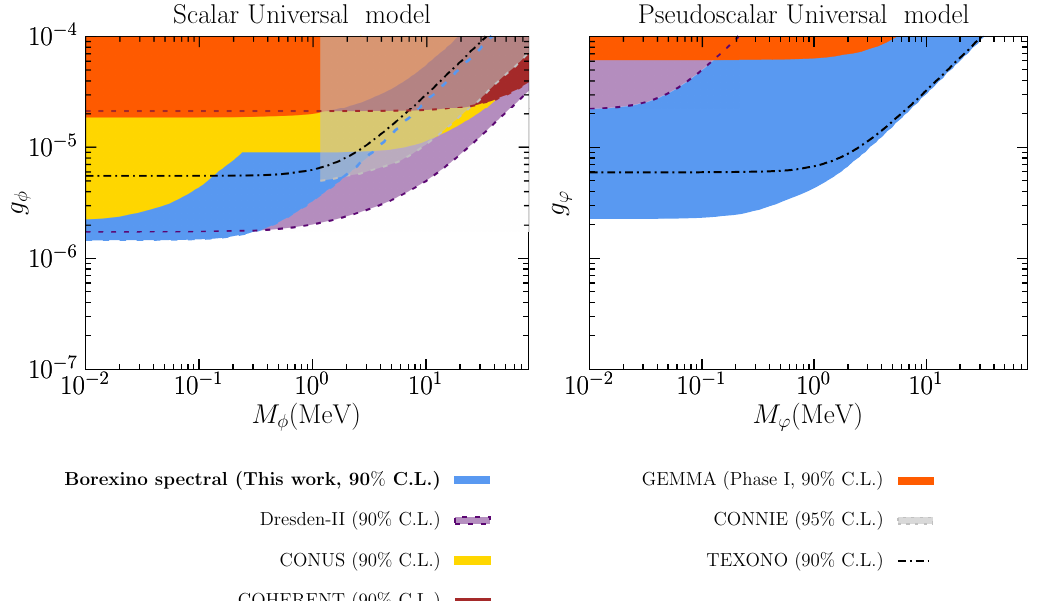
Figure 6 . Bounds from our analysis of Borexino Phase-II spectral data on a scalar (left panel) and pseudoscalar (right panel) mediator (at 90% CL for 1 d.o.f., using two-sided intervals,